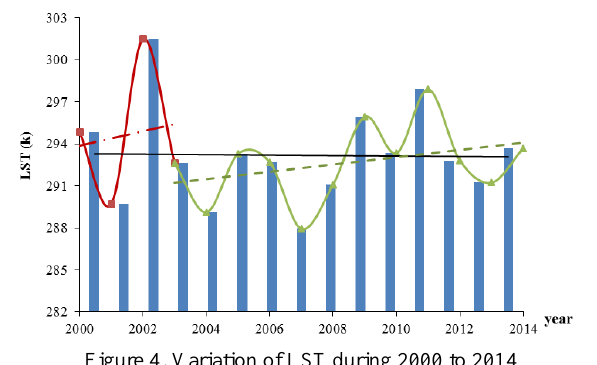
Figure 4. Variation of LST during 2000 to 2014